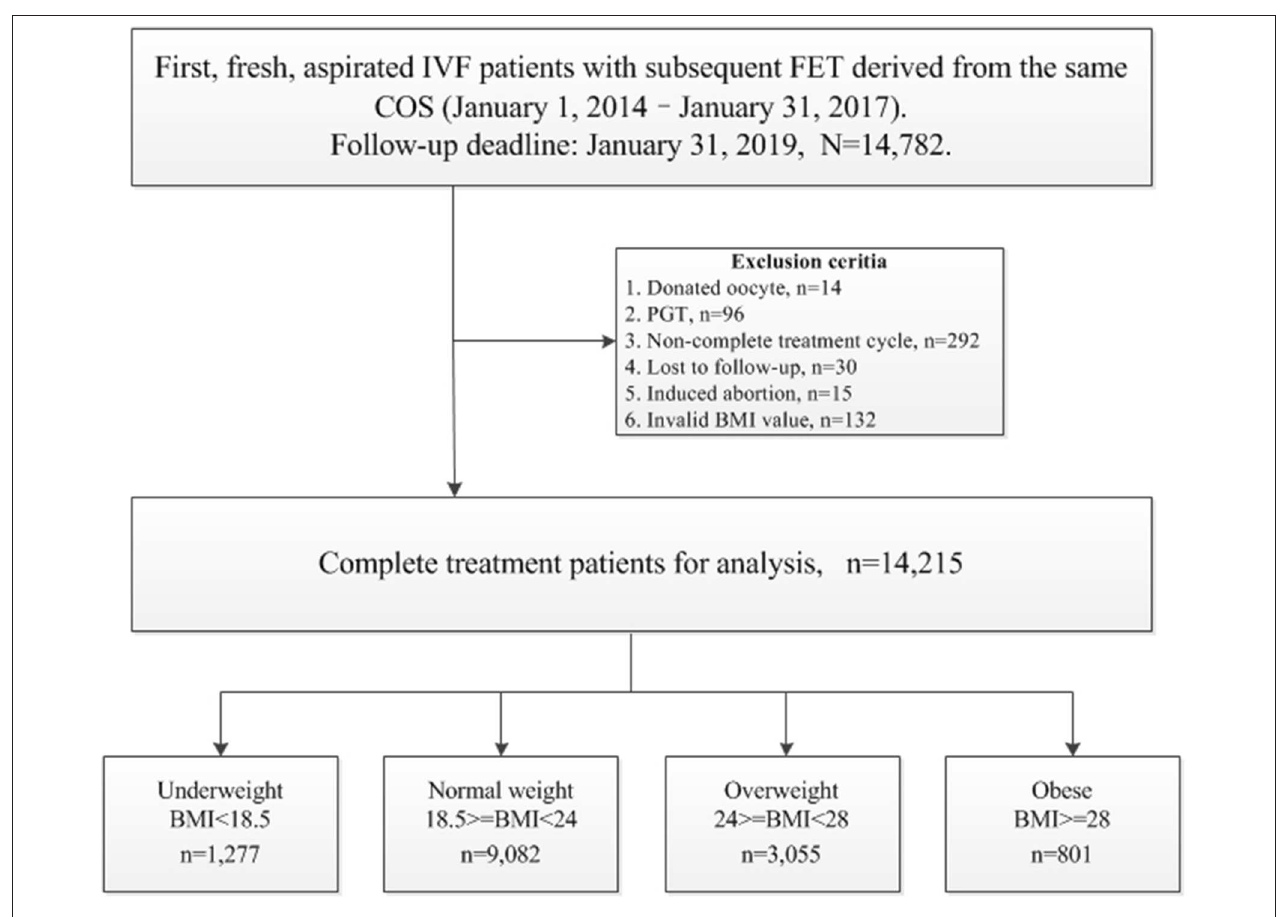
FIGURE 1 | Flow chart and data processing (BMI, kg/m 2